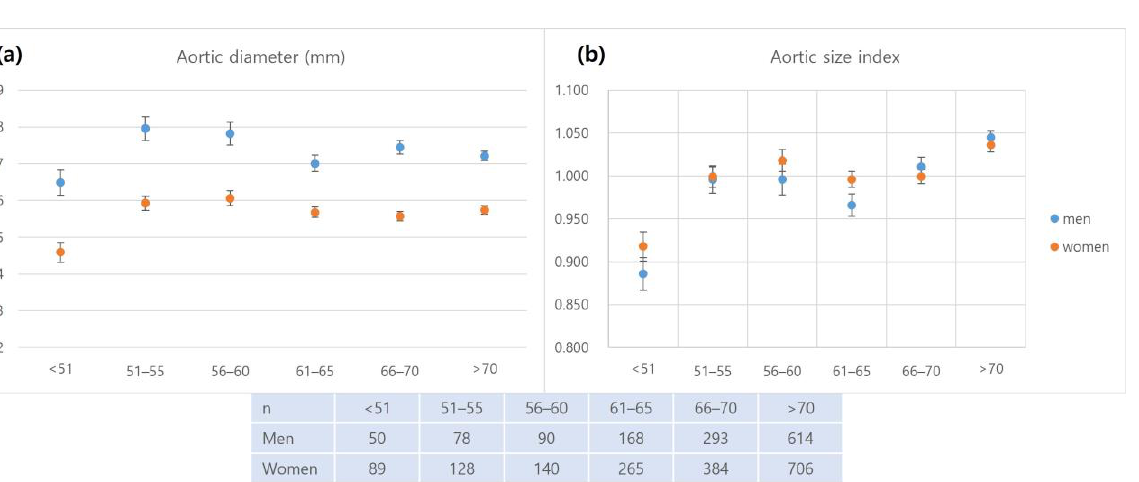
Figure 1. Distribution of the diameters of the aorta and aortic size index according to the age group in the Korean cohort: ( a ). Aortic diameter; ( b ) Aortic size index.